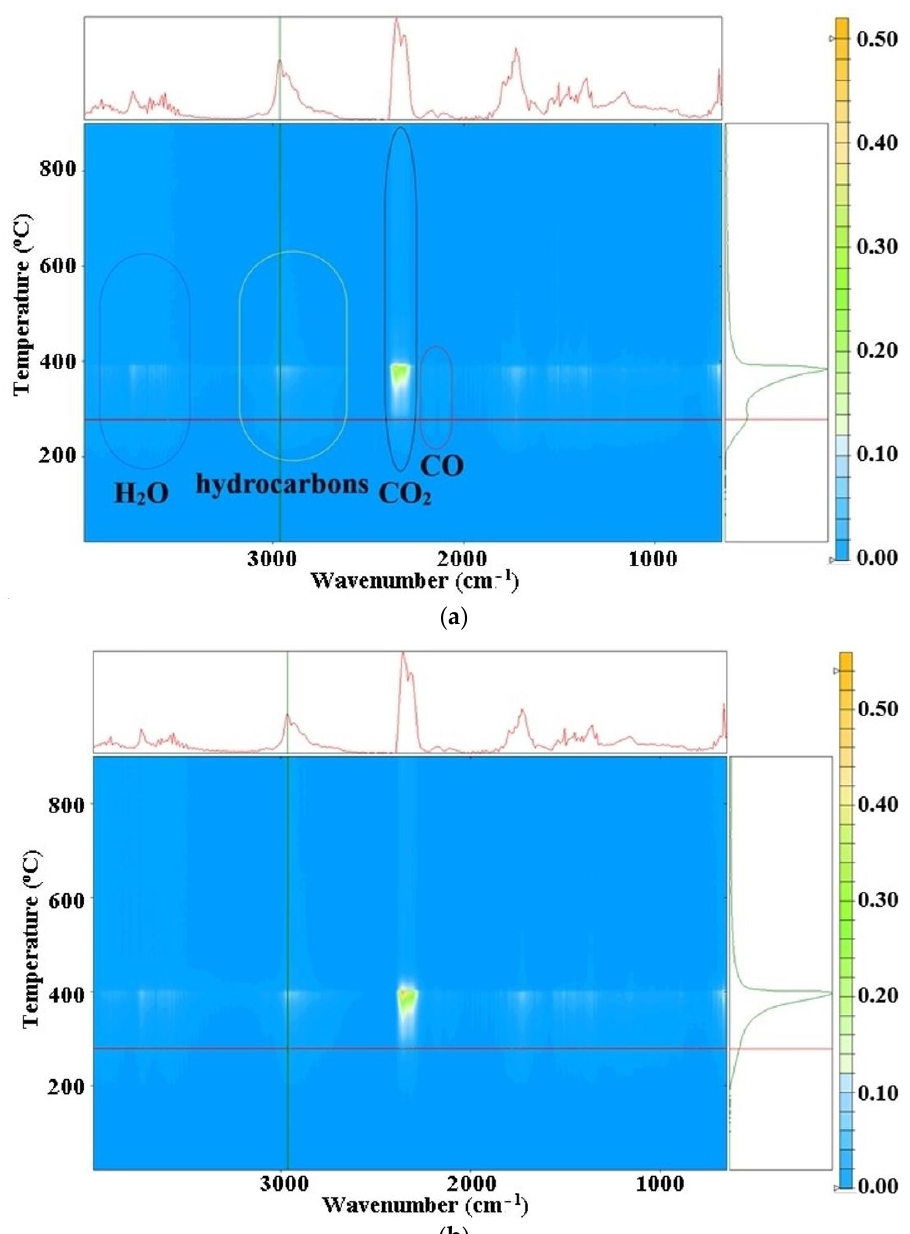
Figure 13. Bidimensional temperature/wavenumber projection for the 3D FTIR plot, indicating the temperature interval where various compounds were found in evolved gases from the thermal analysis of composite membranes: Os-PP1 ( a ); and Os-PP2 ( b ).